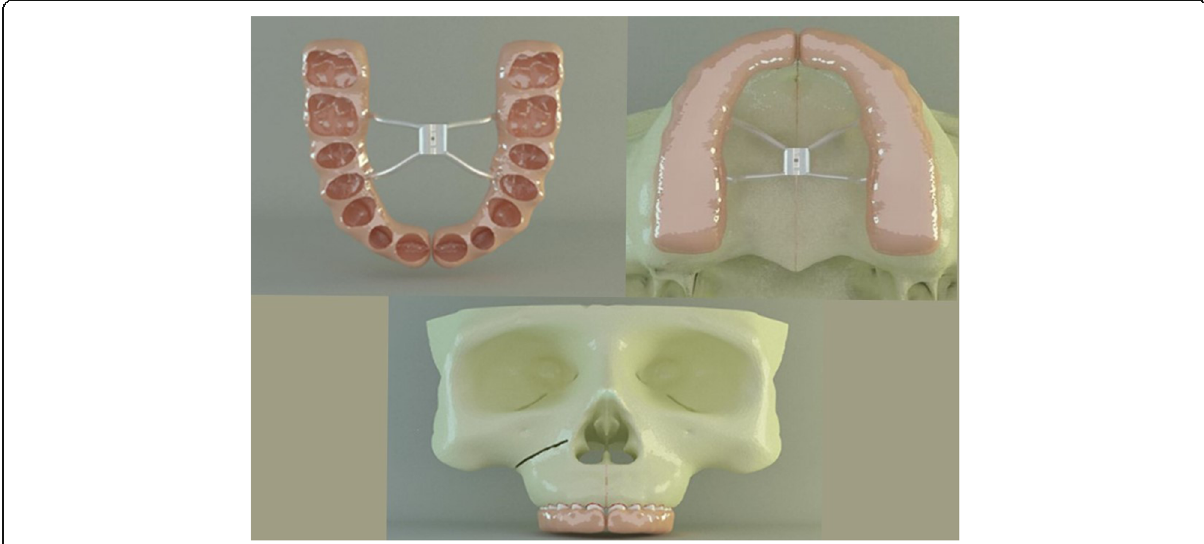
Fig. 3 Inner view of modified full acrylic cap-splint (above left). RME was placed onto the occlusal surfaces of the maxillary teeth (above right). The gingival thirds of the teeth crowns, where the acrylic part of RME ended, were left open to achieve periodontal hygiene (below)